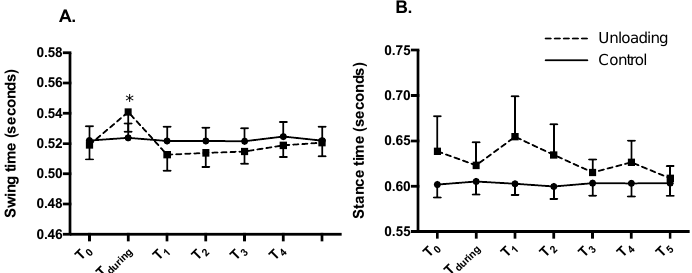
Figure 5. Group means ( ± SEM) of ( A ) swing time and ( B ) stance time across different epochs for the control and unloading conditions. * Significant difference ( p < 0.05) relative to T 0 of the corresponding condition.